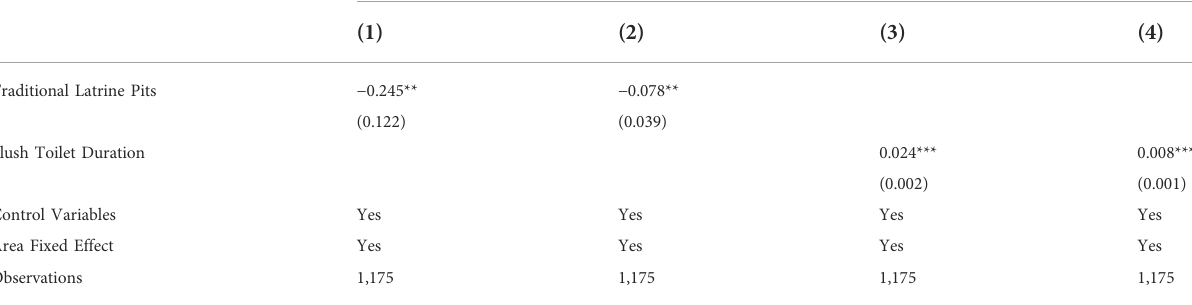
TABLE 5 Robustness checks.